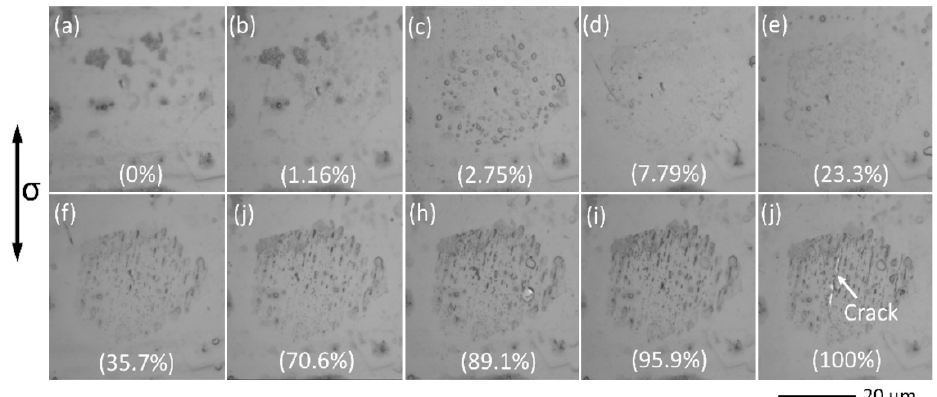
Figure 4. Fatigue crack initiation process at surface slip bands.